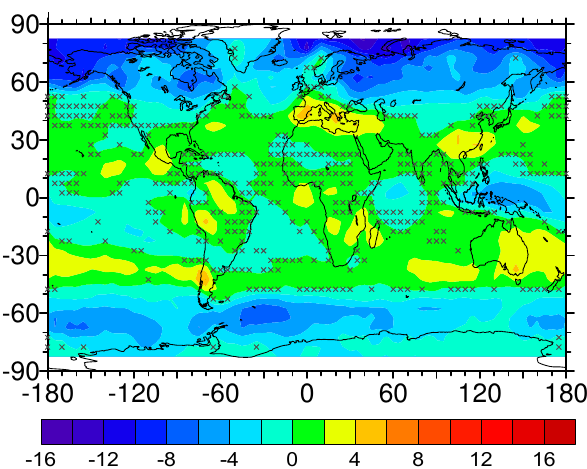
Fig. 1. Multi-model mean changes (%) in annual mean UV CMF. Figure 1. Multi-model mean changes (%) in annual mean UV CMF. Changes are given as averages Changes are given as averages for the period 2090–2099 relative to for the period 2090 - 2099 relative to the period 1960 - 1969. Crosses mark areas where changes are the period 1960–1969. Crosses mark areas where changes are not not statistically significant at the 95% level. statistically significant at the 95%